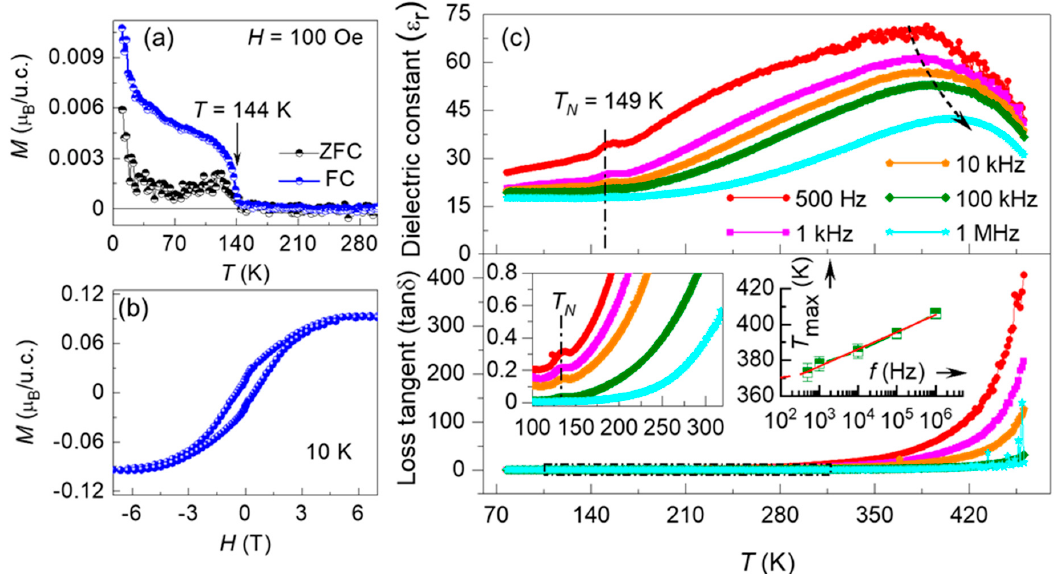
Figure 3. ( a ) The temperature-dependent magnetization M ( T ) curves measured in both the zero-field-cooled (ZFC) and field-cooled (FC) protocols, show a magnetic transition at T = 144 K. ( b ) The in-plane magnetic field dependence of magnetization ( M(H) ) loop of the film at 10 K. ( c ) The temperature dependence of dielectric constant ( ε r ) and loss tangent ( tan δ ) at di ff erent frequencies. The dashed line at 149 K indicates a dielectric anomaly close to magnetic transition. The curved-dash line highlights the relaxor behavior. An enlarged view of the loss data, marked by a narrow-dashed line rectangle, is represented in the left inset, showing that the dielectric anomaly can also be observed in loss tangent curves. The right inset shows a Vogel–Fulcher plot with extrapolated freezing temperature ( T f = 370 K, dashed red line), manifesting the relaxor ferroelectricity in epitaxial YCO films.